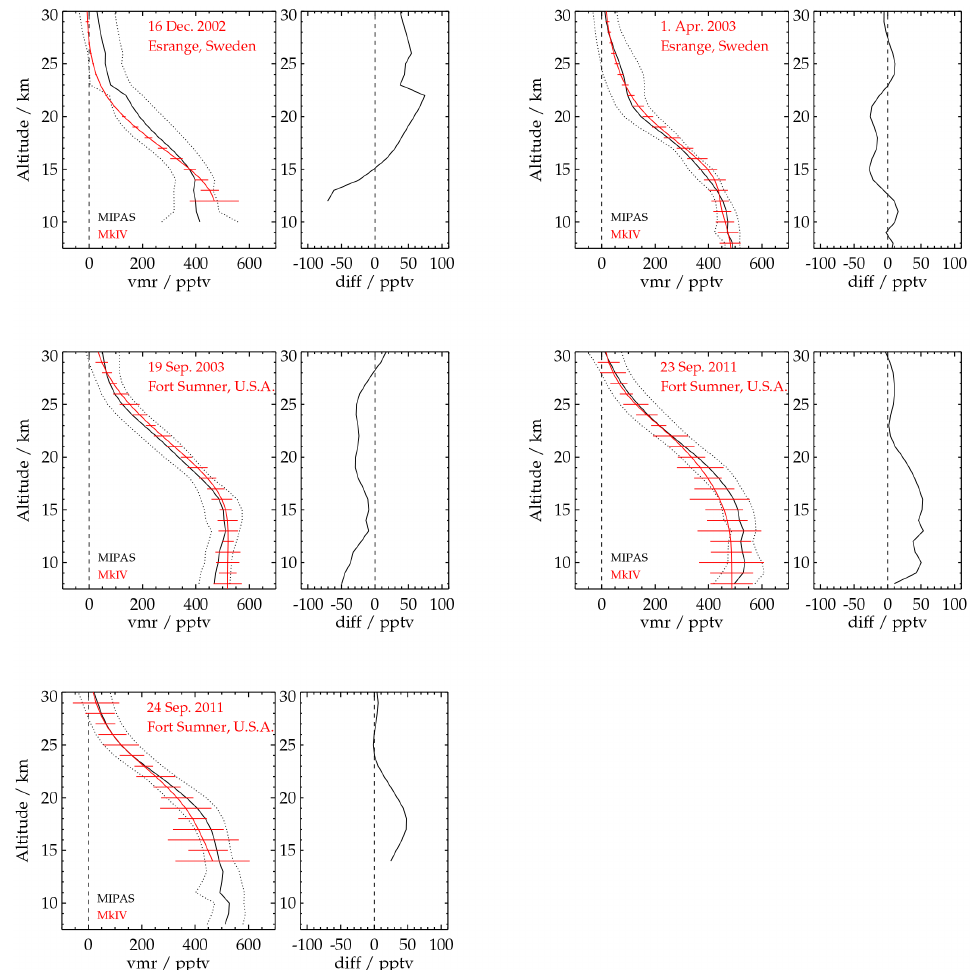
Figure 3. Comparison of MIPAS OCS data (black) with OCS profiles obtained by the MkIV balloon experiment (red) on 16 December 2002 and 1 April 2003 over Esrange, Sweden, (67.9 ◦ N, 21.1 ◦ E, top panel) and on 19 September 2003, 23 and 24 September 2011 over Fort Sumner, New Mexico (34.5 ◦ N, 104.2 ◦ W, middle panel and bottom). For each balloon profile all MIPAS profiles within a radius of 1000km and a temporal offset of 24h (48h for 19 September 2003) were taken into account and averaged, resulting in adding up of 10–14 profiles, respectively. The dotted lines indicate the standard deviation of the MIPAS profiles and the error bars (red) the 1 σ measurement precision of the balloon profiles. The balloon profiles were convolved with the averaging kernels related to one of the collocated MIPAS profiles,